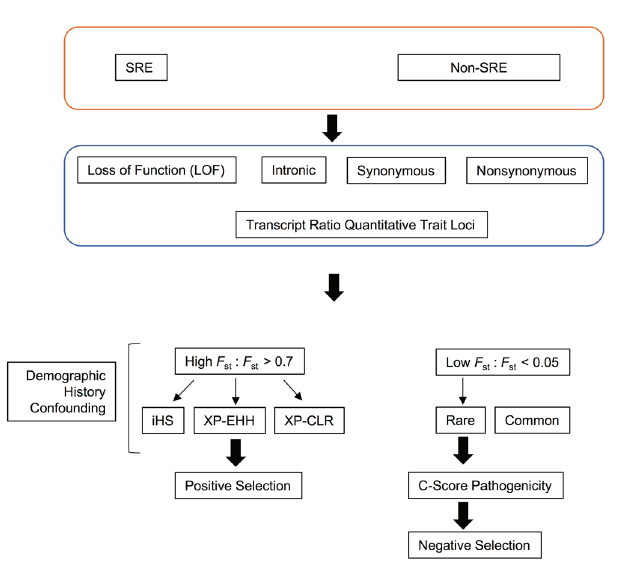
Figure 2. Illustration of overall analytic approach. In our analysis, SRE SNPs and non-SRE SNPs were classified according to four functional categories: LOF, intronic, synonymous and non-synonymous. We also considered the overlap of SRE SNPs with transcript ratio quantitative trait loci (GEUVADIS) and splicing QTLs (GTEx) identified in RNA-Seq studies in LCLs and in human tissues, respectively. We assessed the evidence for high population differentiation and complemented this with evidence for positive selection using (given the potential for confounding due to demographic history) one of 3 additional signatures (iHS, XP-EHH, and XP- CLR). We also evaluated the evidence for negative selection and incorporated a metric of